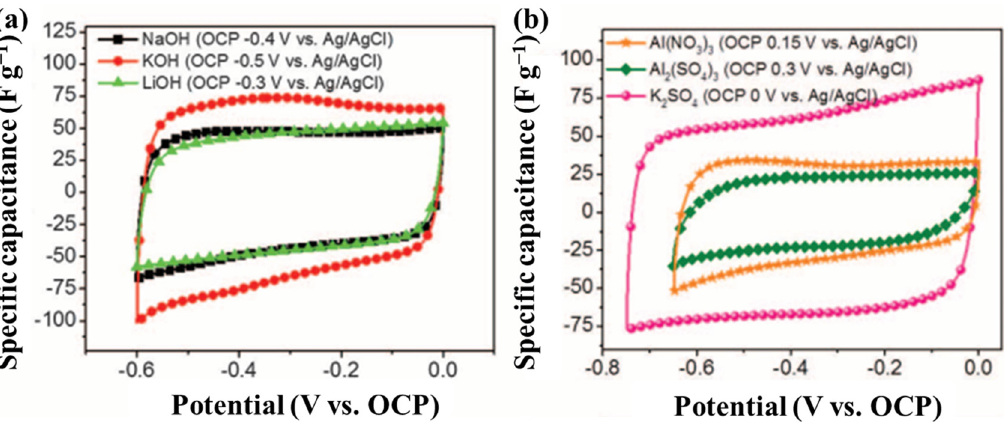
Figure 23. ( a , b ) CV profiles of Ti 3 C 2 T x -based SCs in basic and neutral electrolytes [38].